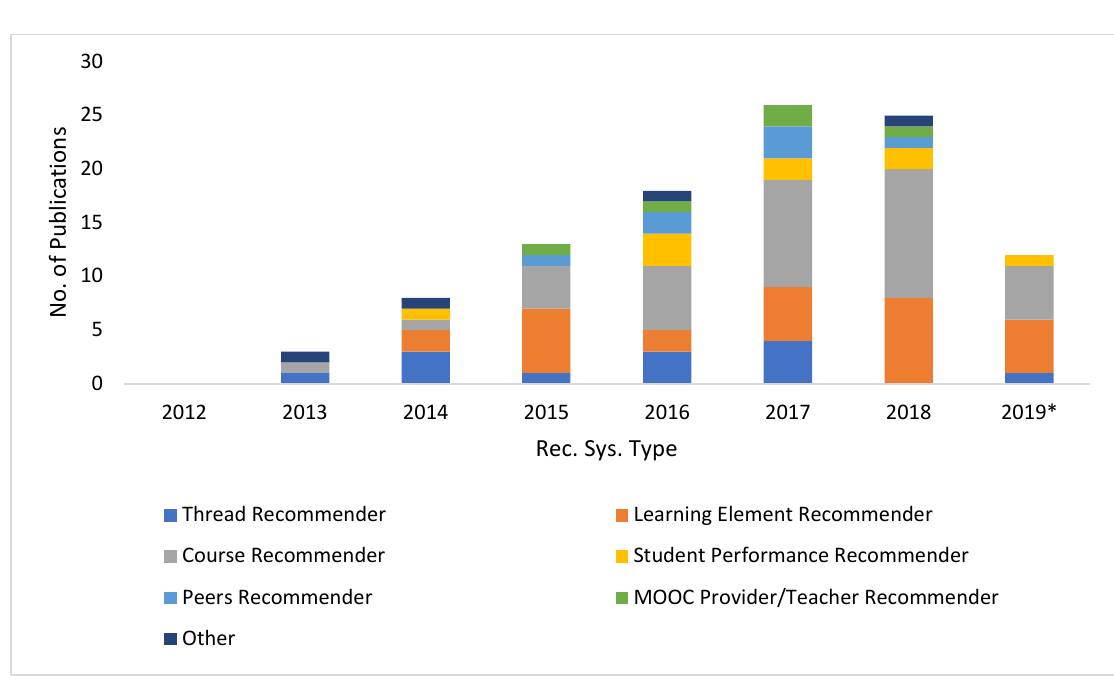
Figure 6. Change over time in the types of recommender systems in MOOCs researched. *2019 data includes research published only up to July 12,